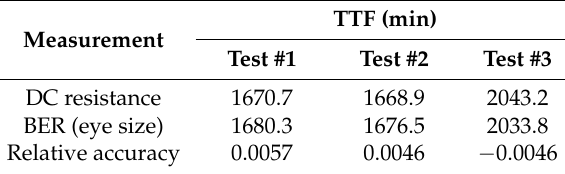
Table 3. Time to failure (TTF) based on the measurement features. DC—direct current.